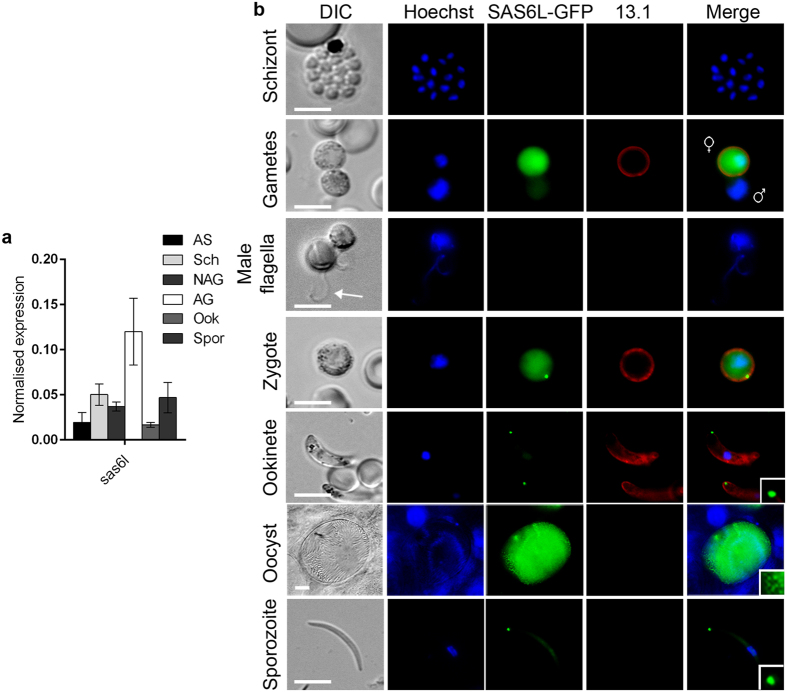
SAS6L gene transcript and protein expression throughout the life cycle in P.berghei.(a) Transcription of sas6l analysed by qRT-PCR, normalised against two endogenous control genes, hsp70 and arginine-tRNA synthetase (Pfaffl method). Each bar is the mean of three biological replicates ± SEM. All asexual blood stages: AS; schizonts: Sch; non-activated gametocytes: NAG; activated gametocytes: AG; ookinete: Ook; 14 dpi oocysts/sporozoites: Spor. (b) Live fluorescence detection of SAS6L-GFP in blood-stage schizont, female and male gametes, male gamete with flagella, zygote, ookinetes, oocyst (14 dpi) and sporozoite (21 dpi). 13.1, a cy3-conjugated antibody which recognises P28 on the surface of activated female, zygote, and ookinete (red) was used with the sexual stages. Nuclei were detected using Hoechst 33342 (blue), and the cells were displayed by differential interference contrast (DIC). Merge is the composite of Hoechst, GFP and 13.1 signals. Insets show magnified view of SAS6L-GFP dots. White arrow points to single flagellated male gamete. Scale bars = 5 μm.